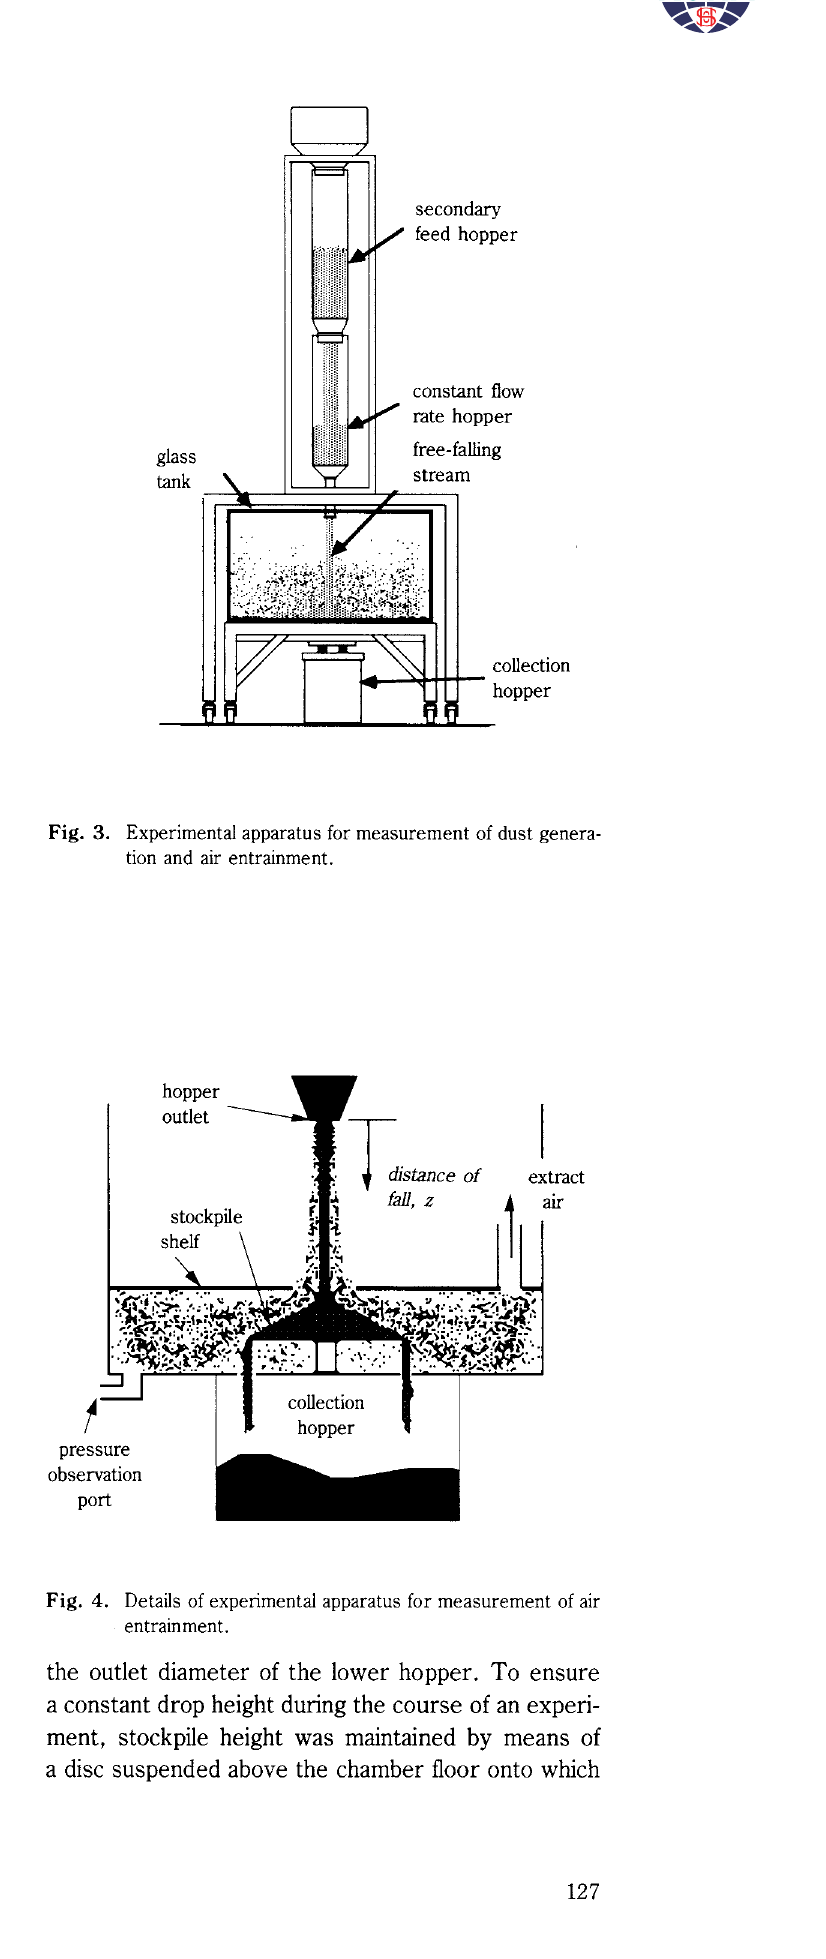
Fig. 3. Experimental apparatus for measurement of dust genera tion and air entrainment.